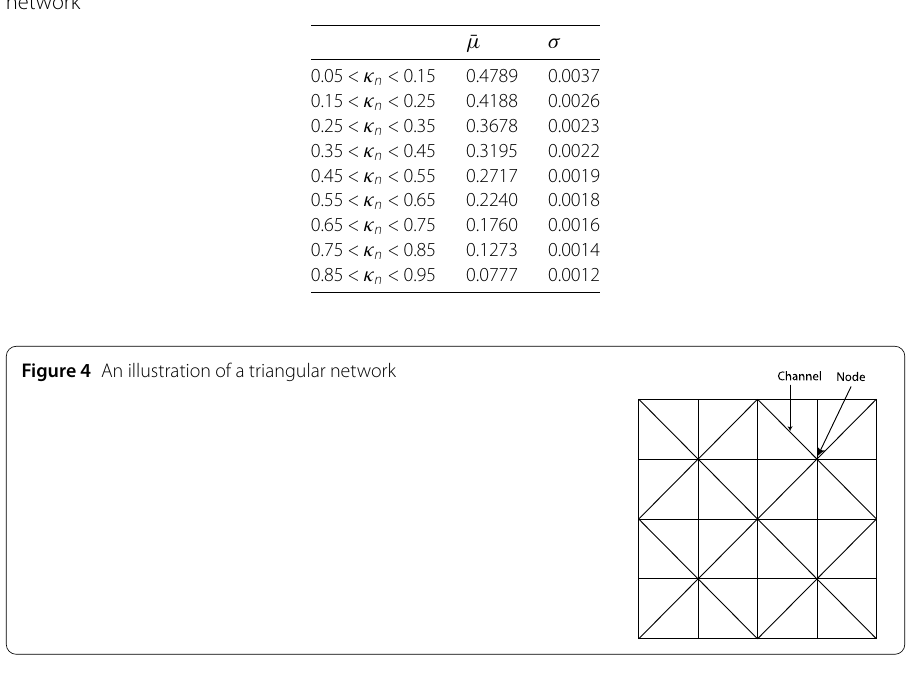
standard deviation σ of the distribution of f c depend on the normalised permeability κ n as presented in Table